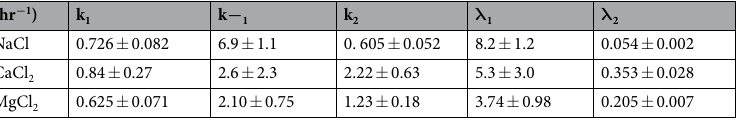
Table 1. Rate constants ( ± standard error) for oxaliplatin degradation reactions in NaCl (150 mM), CaCl 2 (75 mM) and MgCl 2 (75 mM) at 37